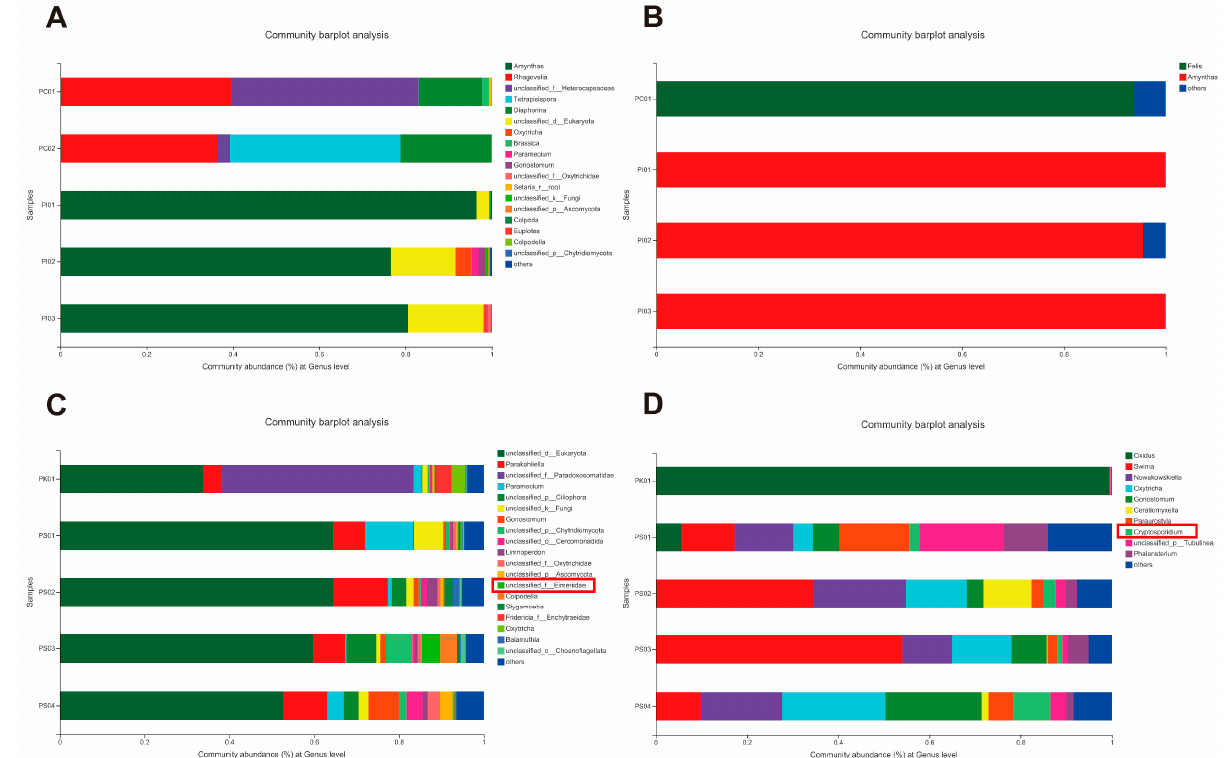
Figure 3. Composition of parasites in environmental samples at genus level. Different colors indicate different groups, with details shown on right side of each figure, respectively. PC01 and PC02 represent livestock manure samples (fed to earthworms); PI01, PI02, and PI03 represent earthworm food samples; PK01 represents cricket food sample; PS01, PS02, PS03, and PS04 represent soil samples. ( A , B ) show composition of parasites in livestock manure and earthworm food samples. ( C , D ) show composition of parasites in cricket food and soil samples. Parasites discovered in the current study are contained within rectangle.